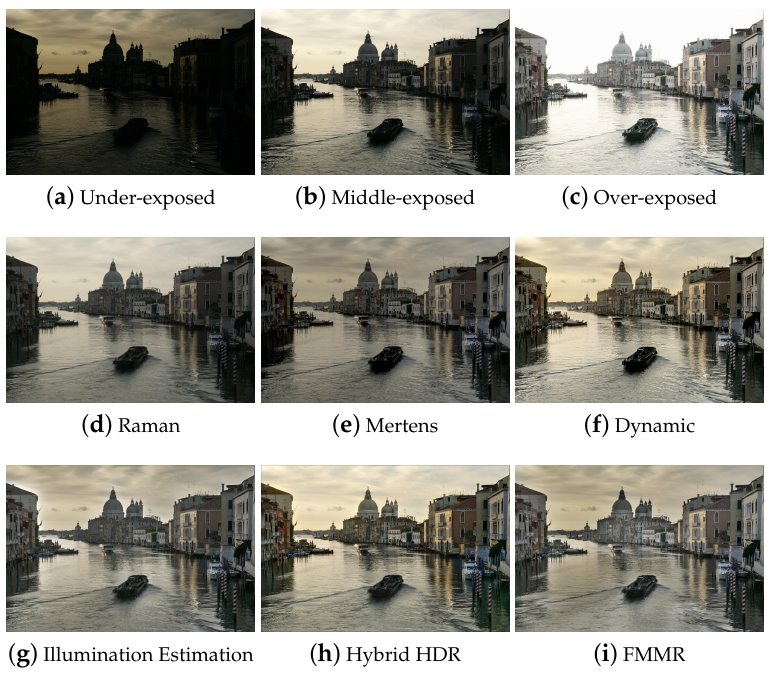
Figure 5. Comparison of the six MEF algorithms using the “Venice”